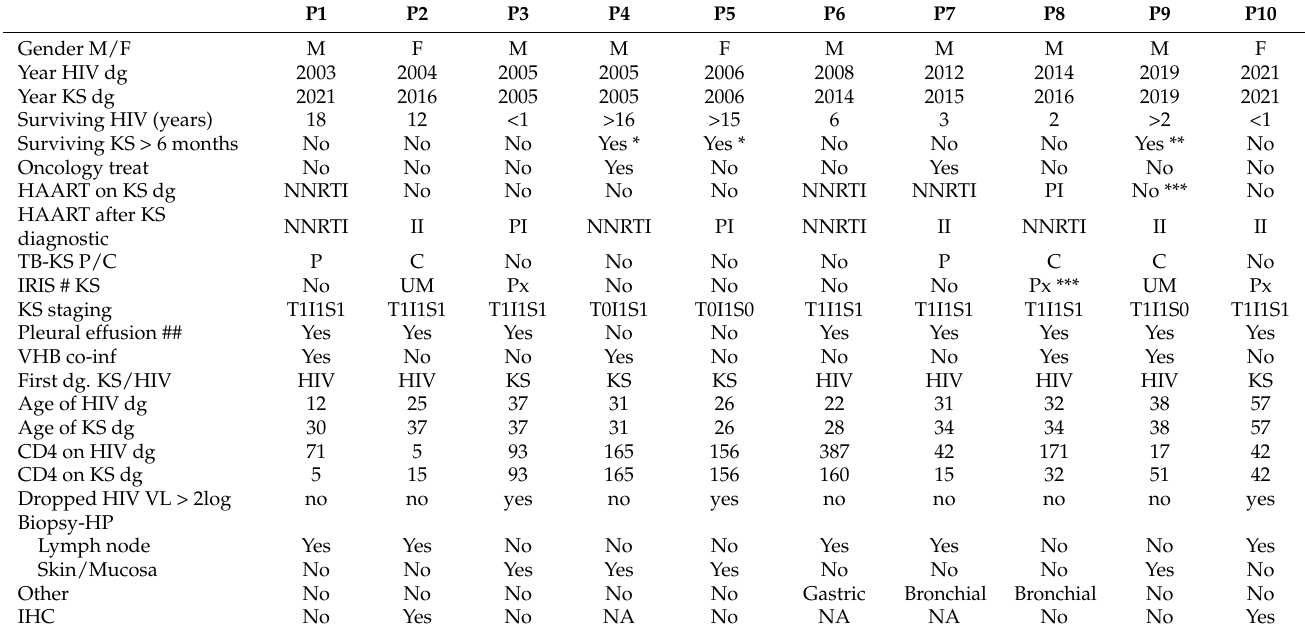
Table 1. Individual Characteristics of HIV patients with Kaposi’s Sarcoma: 1 July 2001–30 June 2021.